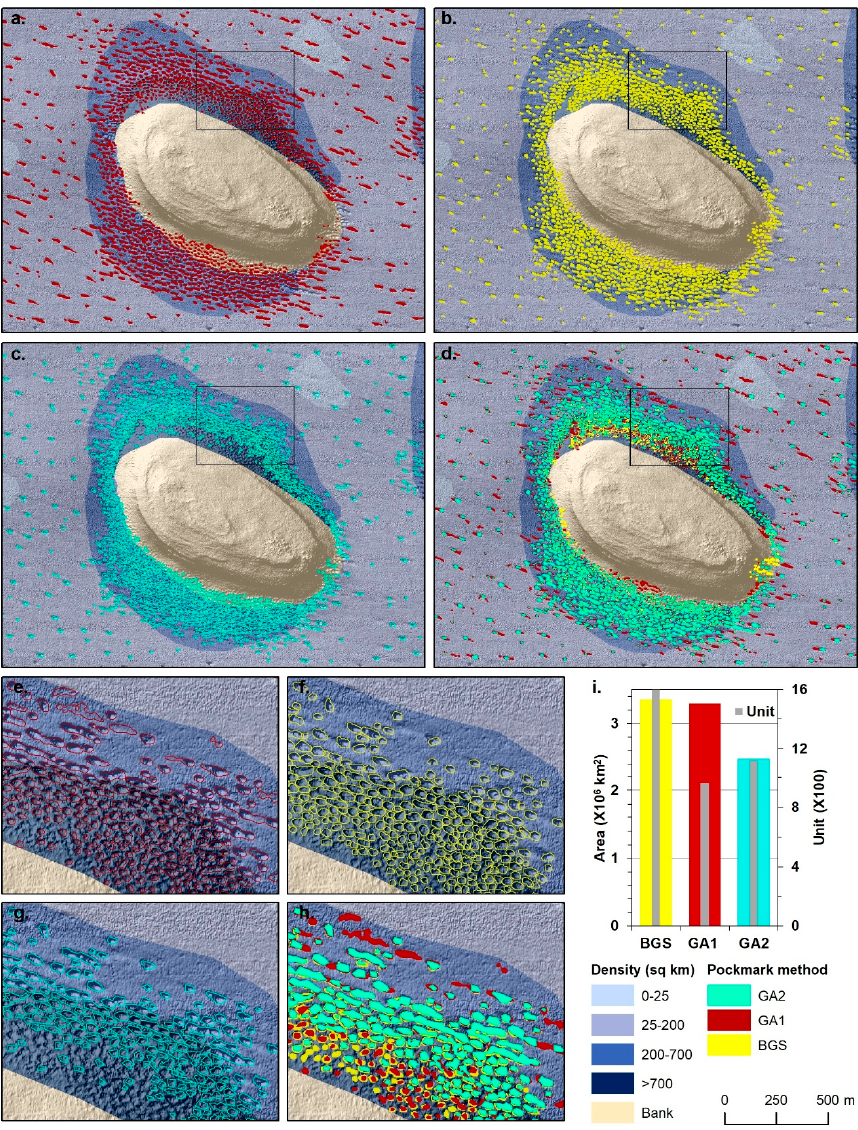
Fig 7 Figure 7. Examination of pockmarks identified using the three methods: GA1 (red), British Geological Survey (BGS) (yellow), GA2 (blue). Panels ( a – d ) show the picks using the various methods for the entire test area, while panels ( e – h ) show an inset of the test area in order to present more details. ( i ) Histogram comparing the total pockmark count (grey bars) and coverage area (coloured bars) between the three automated methods used to identify